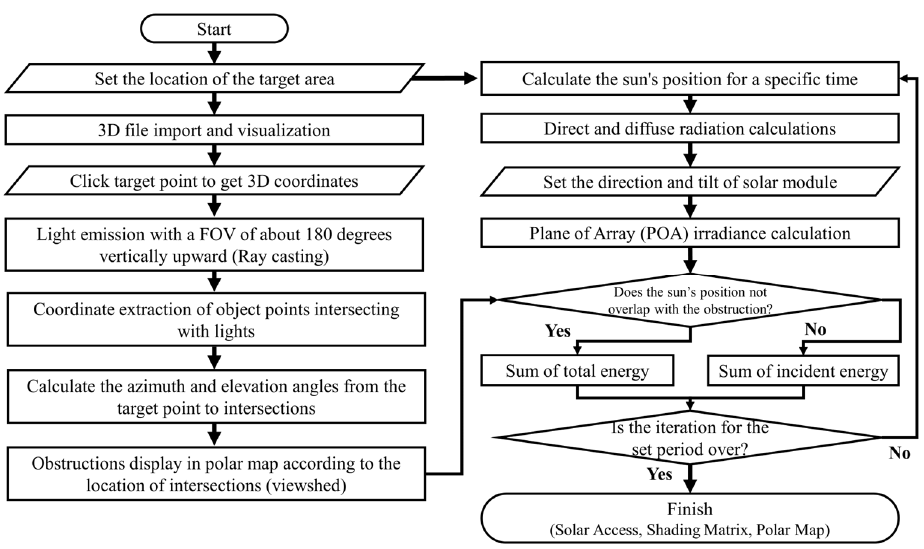
Energies 2023 , 16 , x FOR PEER REVIEW Figure 4. Flowchart showing the procedure of the developed technology. Figure 4. Flowchart showing the procedure of the developed technology.